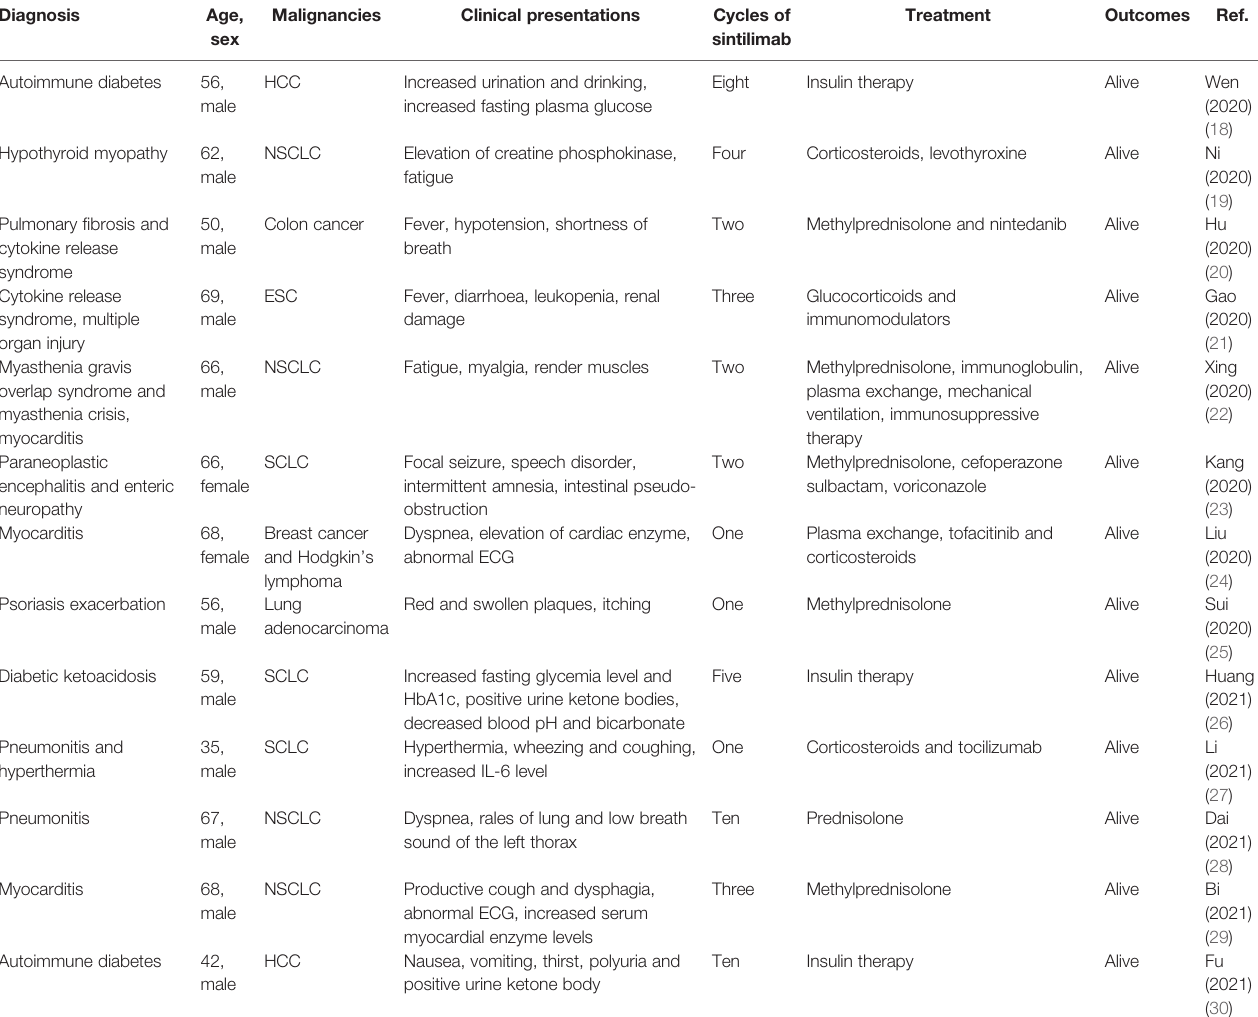
TABLE 1 | Sintilimab-related adverse events based on available case